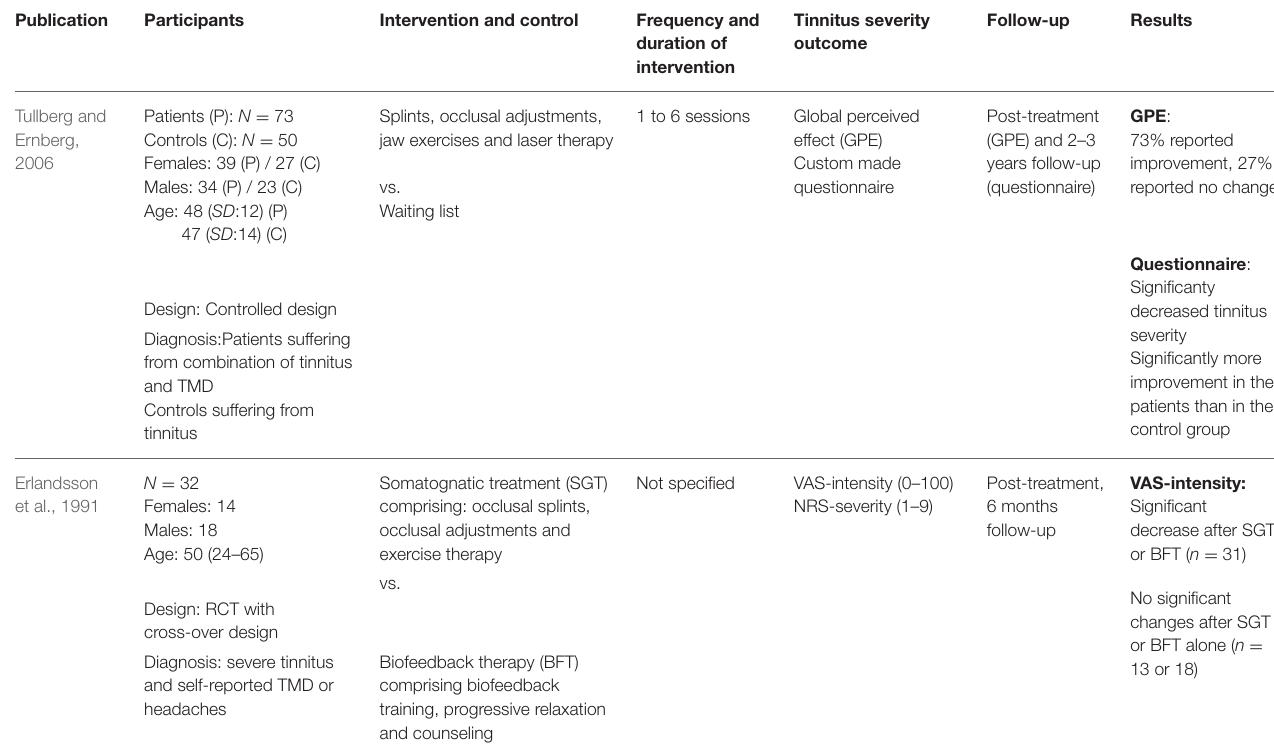
TABLE 2 | Summary of studies concerning temporomandibular